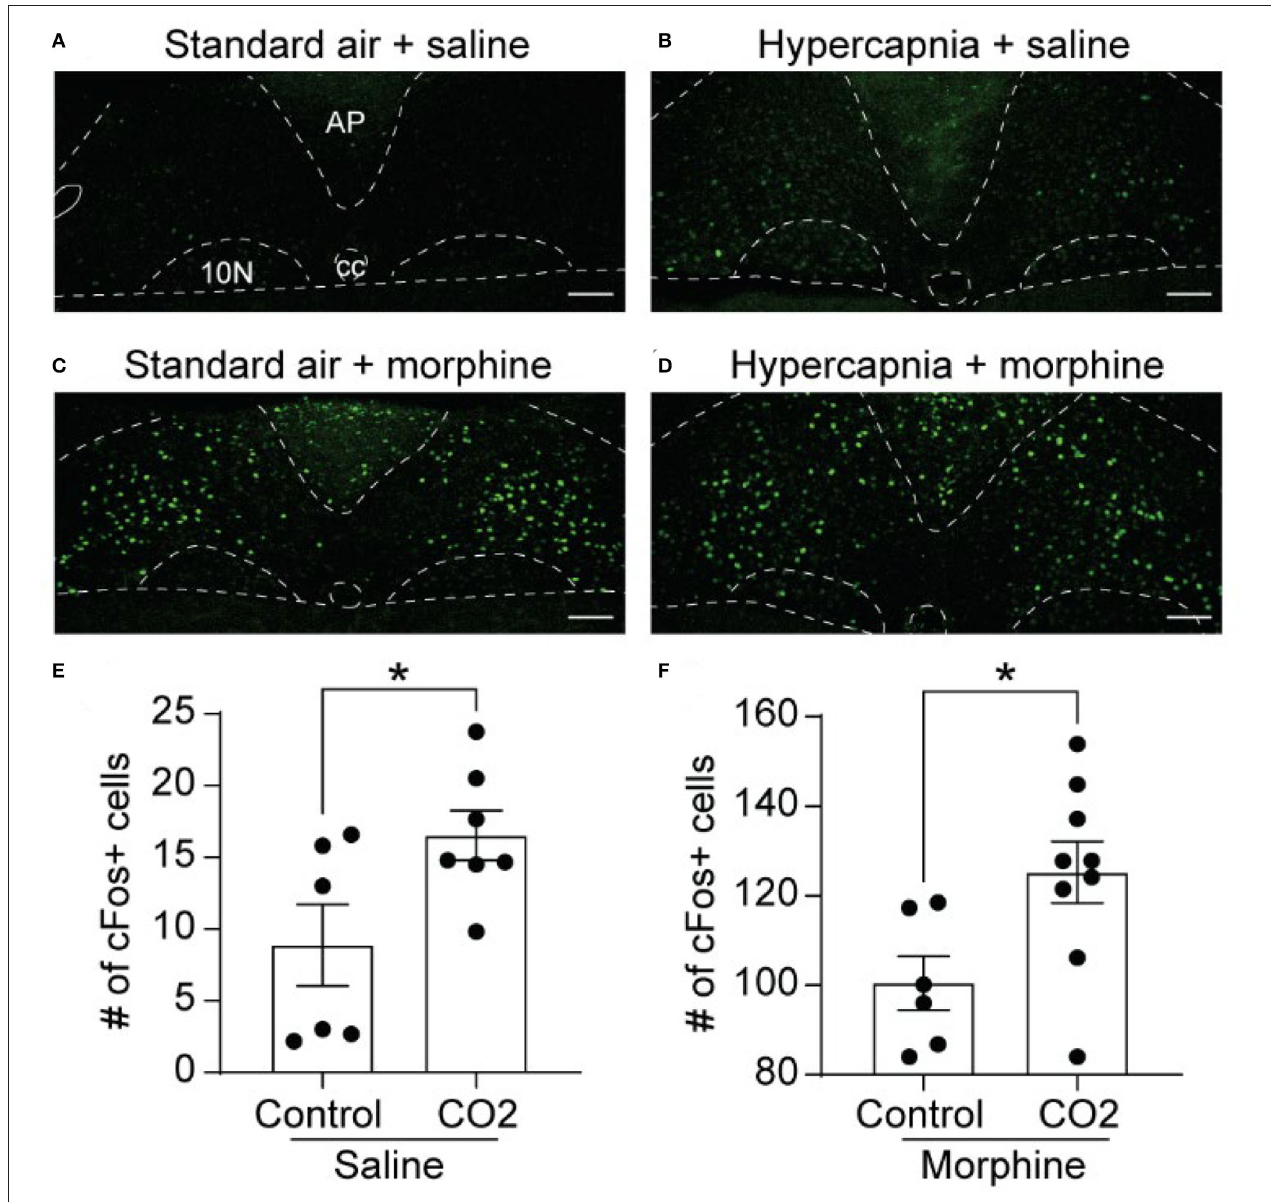
FIGURE 2 | Hypercapnia and morphine activate non-overlapping populations of NTS neurons. Wild-type mice were exposed to standard room air (Control) or hypercapnia (7% CO 2 ) following an injection of saline or morphine (30 mg/kg). (A–D) Example images of cFos immunolabeling (green) in NTS sections from mice exposed to each of the four treatment groups. Scale bar = 100 µ m. AP, area postrema; cc, central canal; 10N, dorsal motor nucleus of vagus. (E,F) Summary data of the average number of cFos + NTS cells per section ( n = 6–9 mice/group, 2–6 sections/mouse). Hypercapnia increased the number of cFos + cells in saline (E) and morphine (F) treated mice. Each data point represents the average # of cFos + cells per section for an individual mouse. Bar and error are group mean ± SEM. * p < 0.05 by unpaired t- test.